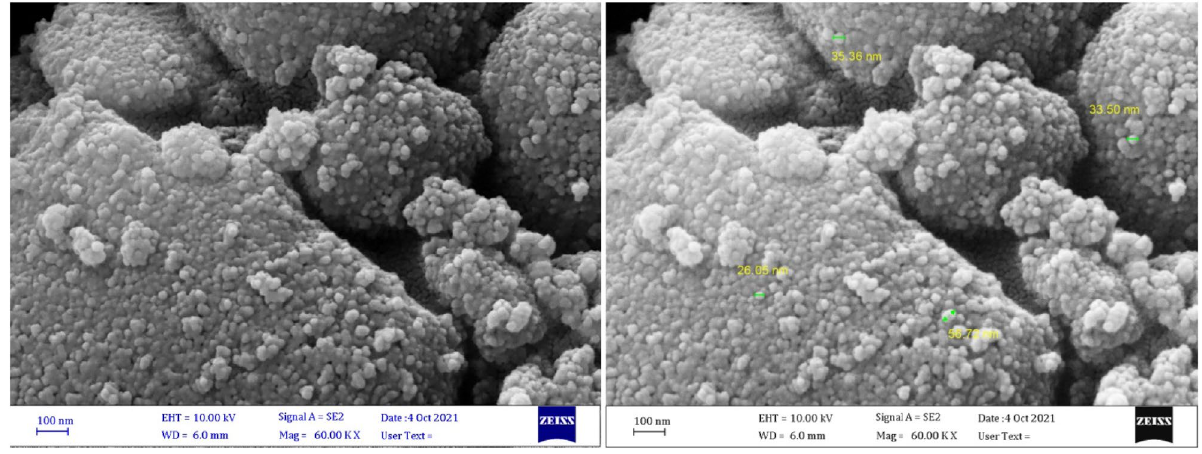
Figure 4. SEM images of Fe 3 O 4